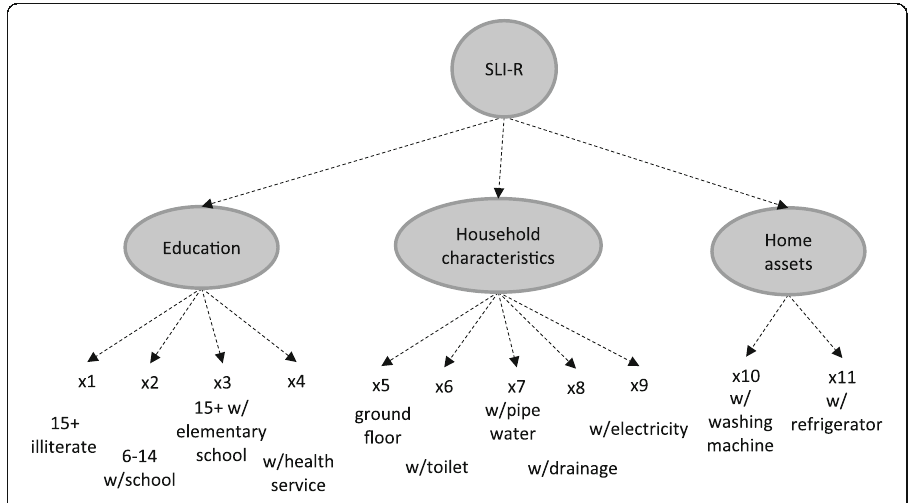
Fig. 1 Social Lag index revised (SLI-R) using a second-order